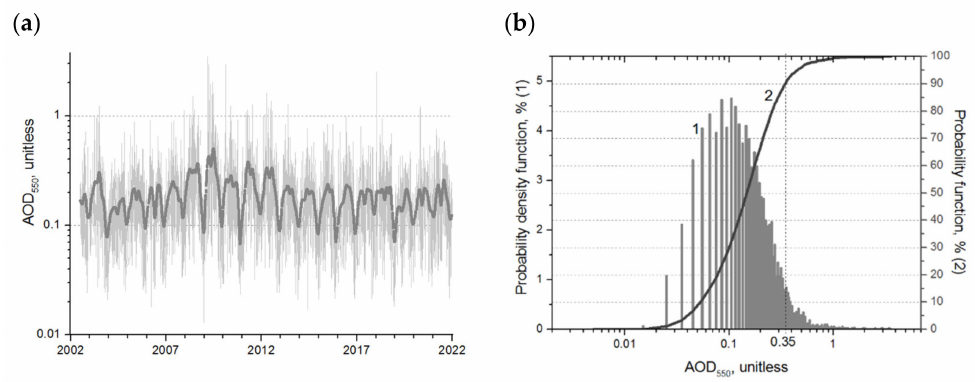
Figure 9. ( a ) Variations of Aqua MODIS daily (thin line) and monthly mean (bold line) aerosol optical depth at 550 nm (AOD 550 ) over the Urmia Lake region (by the seven cells averaged) in 2002–2021. ( b ) Probability density function (histogram; 1) and probability function (bold line; 2) of AOD 550 over Urmia Lake region (averaged over the seven cells) in 2002–2021. The number at the vertical dotted line is the lower limit of the 10% highest AOD 550 .